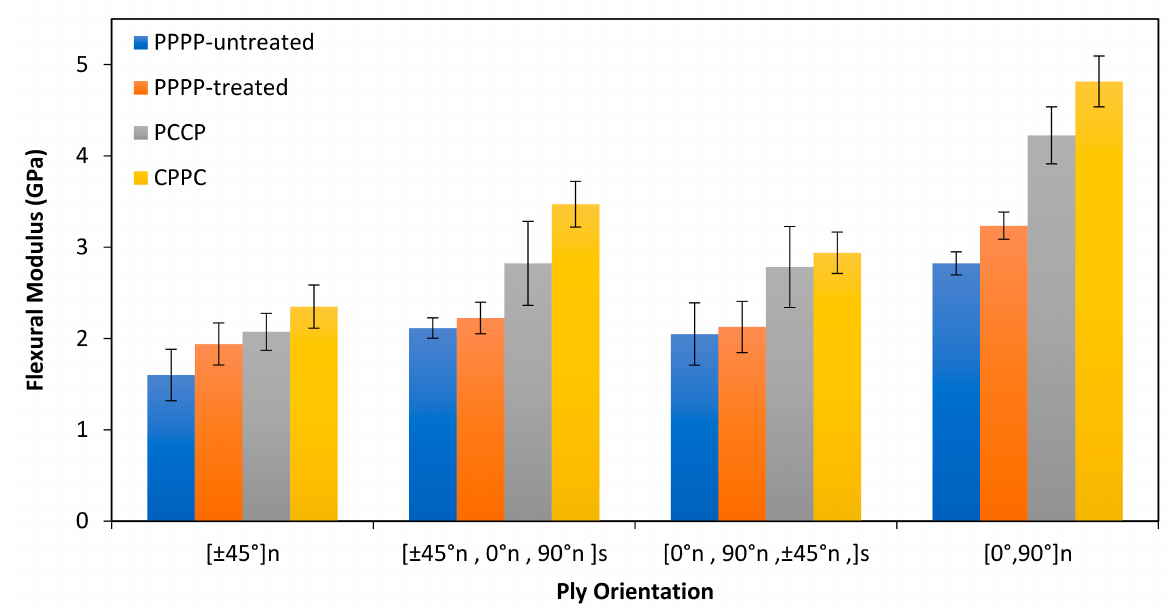
Figure 5. Flexural modulus of PALF/carbon hybrid laminate composites with different ply